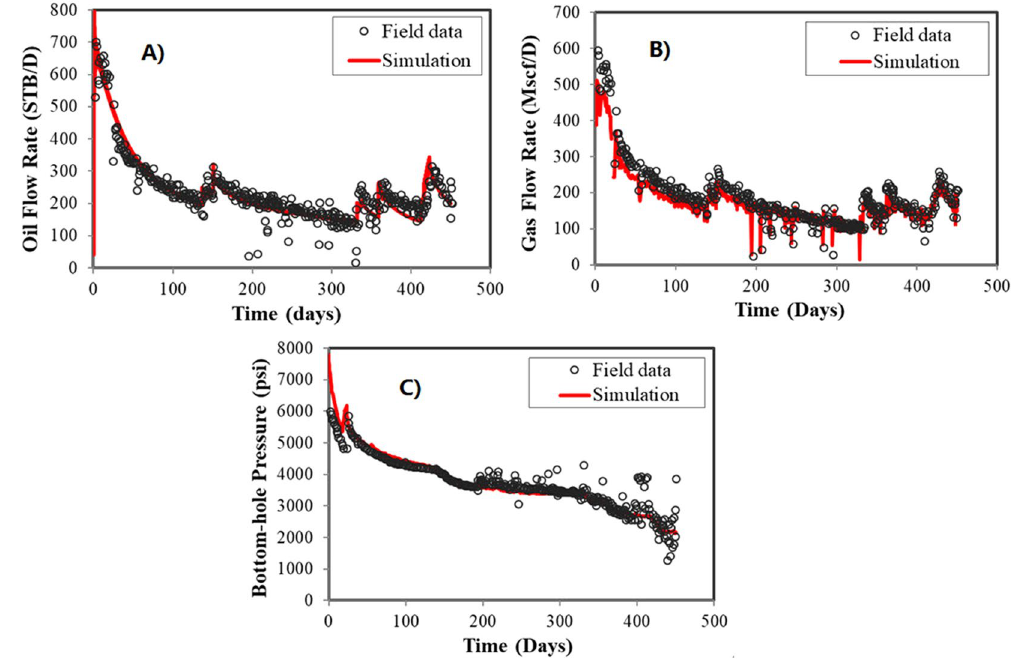
Figure 5. History matching results for the field case study with confinement effect. ( A ) Oil flow rate. ( B ) Gas flow rate. ( C ) Bottomhole pressure.